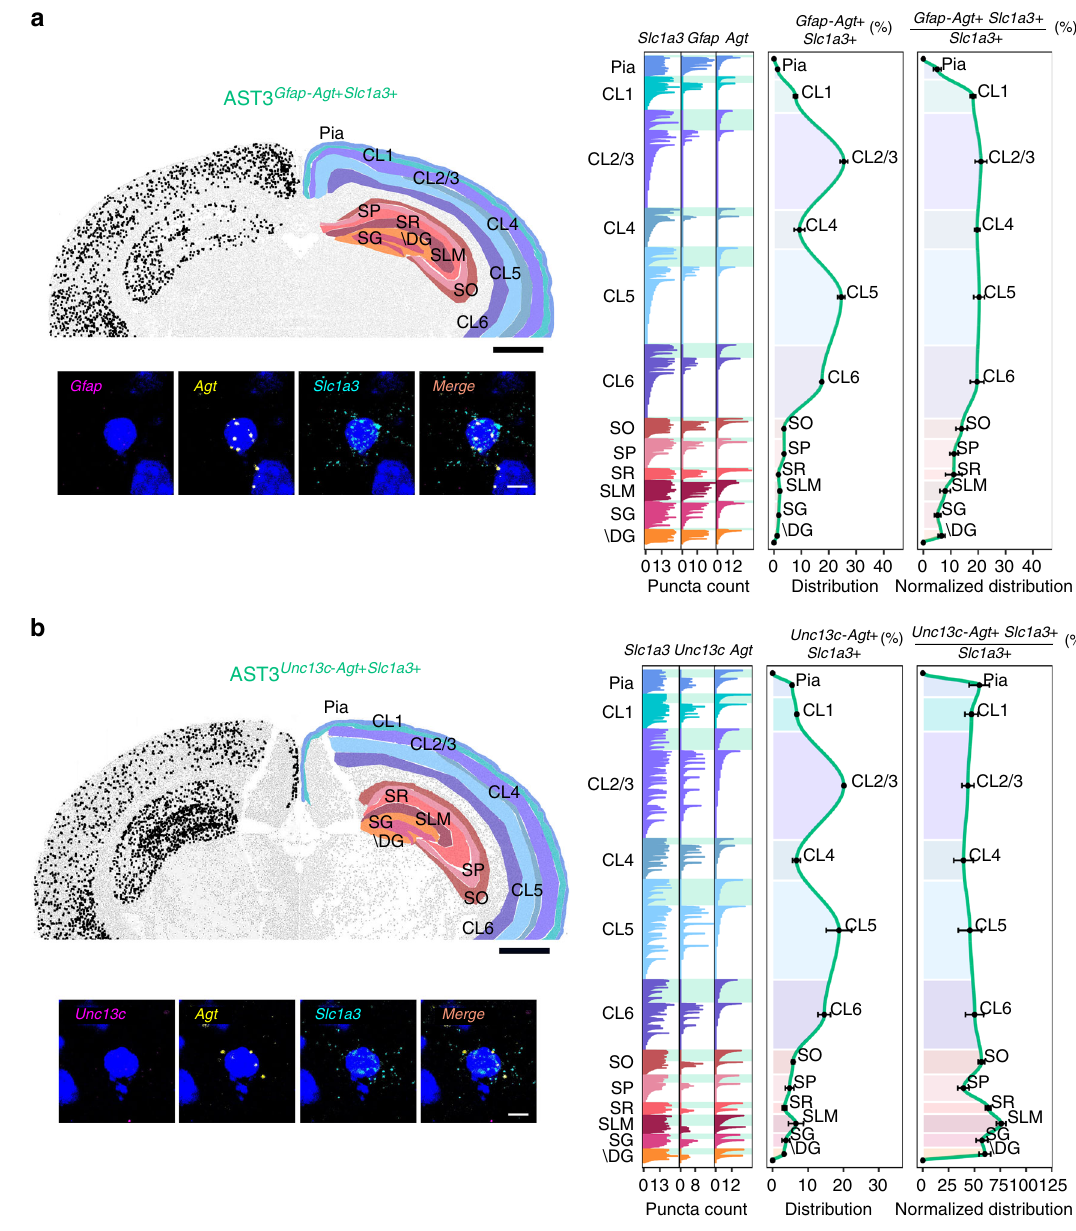
Fig. 6 Differential patterning of AST3 in adult mouse brain. Multiplexed fl uorescence in situ hybridization was used to map the location of AST3. Due to technical limitations, AST3 was mapped using a split marker approach. Sections were assessed for ( a ) low expression/absence of Gfap with expression of Agt and Slc1a3 (to differentiate AST3 from AST1) and ( b ) low expression/absence of Unc13c with expression of Agt and Slc1a3 (to discriminate between AST3 and AST2). Mapping was on three sections from three independent animals aged P56 – P60. Representative images are shown. Top left: low- magni fi cation image of a coronal section. Black dots show astrocyte subtype distribution through one hemisphere. Regions are de fi ned manually based on the Allen Brain Atlas. High-magni fi cation images (below) show the localization of markers to speci fi c cells based on nuclear (DAPI, blue) staining. Right: bar plots (showing left to right) fl uorescence counts per marker per cell (for all cells across all sections analyzed), the distribution of the subtype between brain regions and the distribution of the subtype normalized to the number of astrocytes per brain region (all Slc1a3 + cells). Astrocytes belonging to the subtype of interest are highlighted by a shaded box (color-coded according to the scheme used in Fig. 2a). Astrocyte numbers across layers are given as average per section analyzed. Error bars are equivalent across the fi gure and represent SEM. Scale bars, low magni fi cation 1000 µ m; high magni fi cation, 10 µ m. “ + ” high gene expression, “ − ” low or absent gene expression. SO Stratum oriens, SP Stratum pyramidale, SR Stratum radiatum, SG Subgranular zone, \DG Dentate gyrus without SG, SLM Stratum